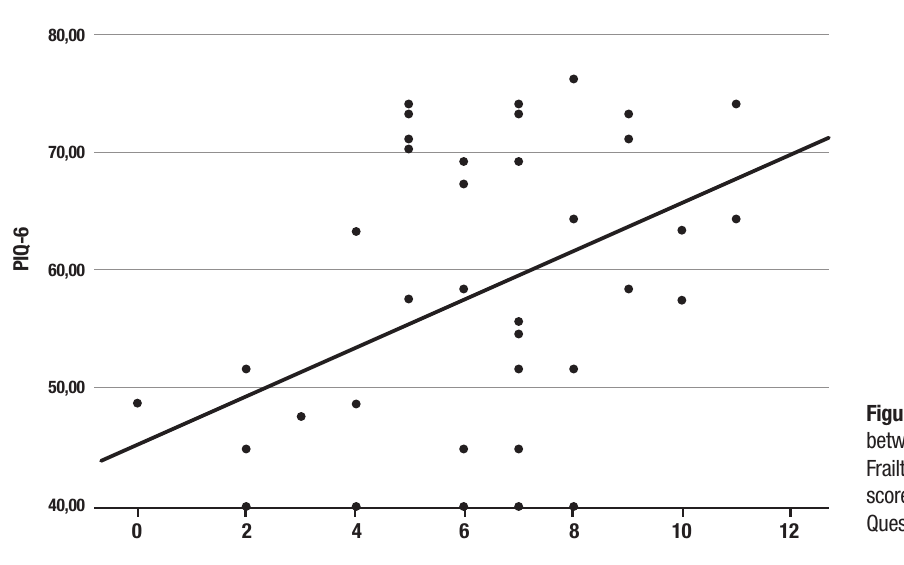
Figure 1. Correlation between Tilburg Frailty Indicator (TFI) score and Pain Impact Questionnaire